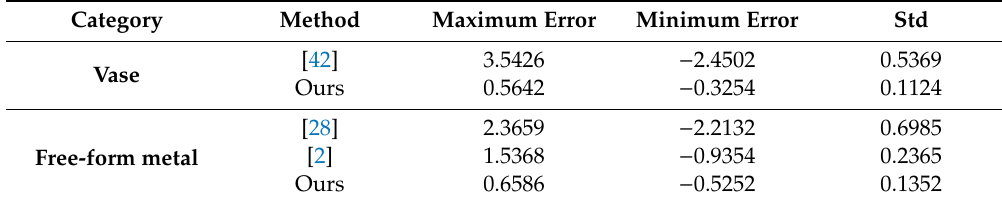
Table 2. Comparisons of reconstruction results of the free-form surface (mm).